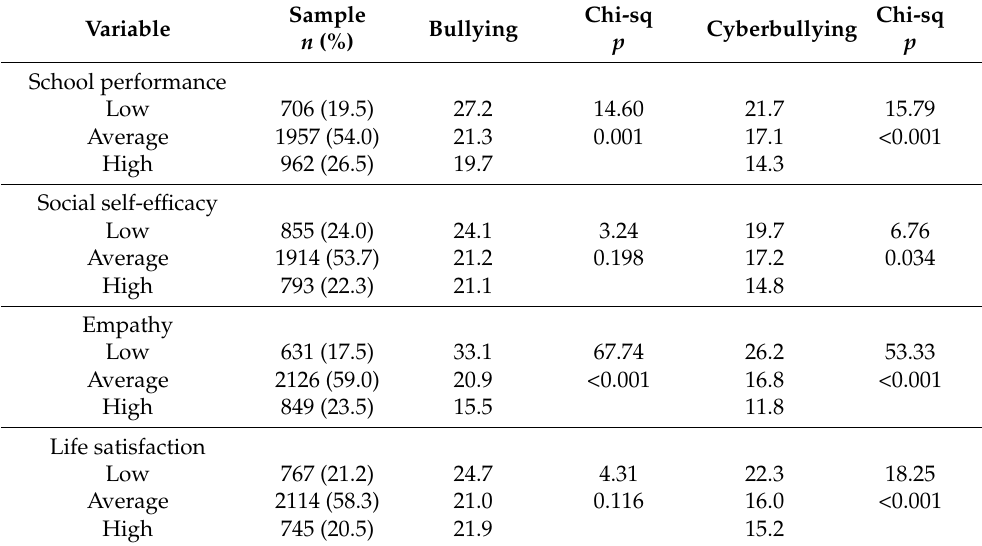
Table 2. Participation in bullying and cyberbullying as perpetrators at least once in the past two months (%) according to individual